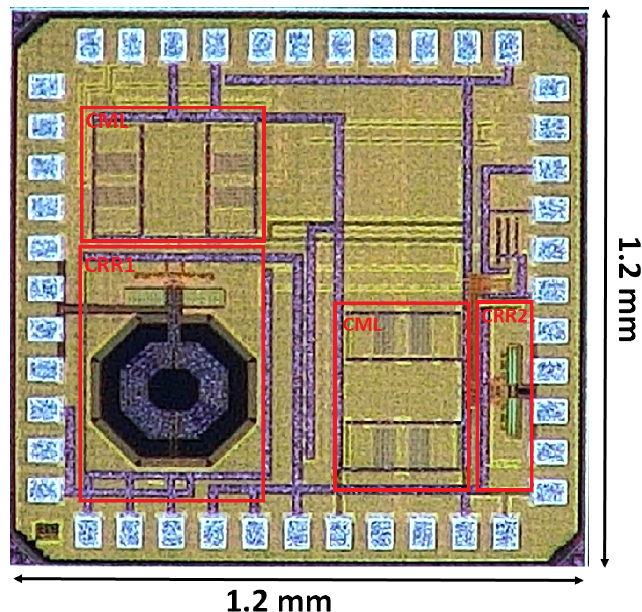
Figure 5. Die micrograph.